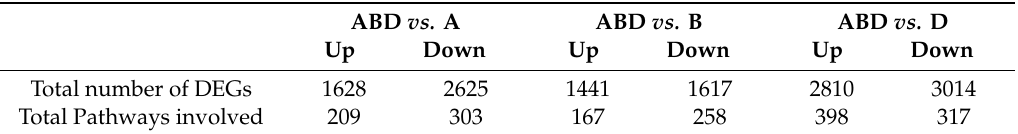
Table 6. Number of DEGs and pathways involved in each comparison.